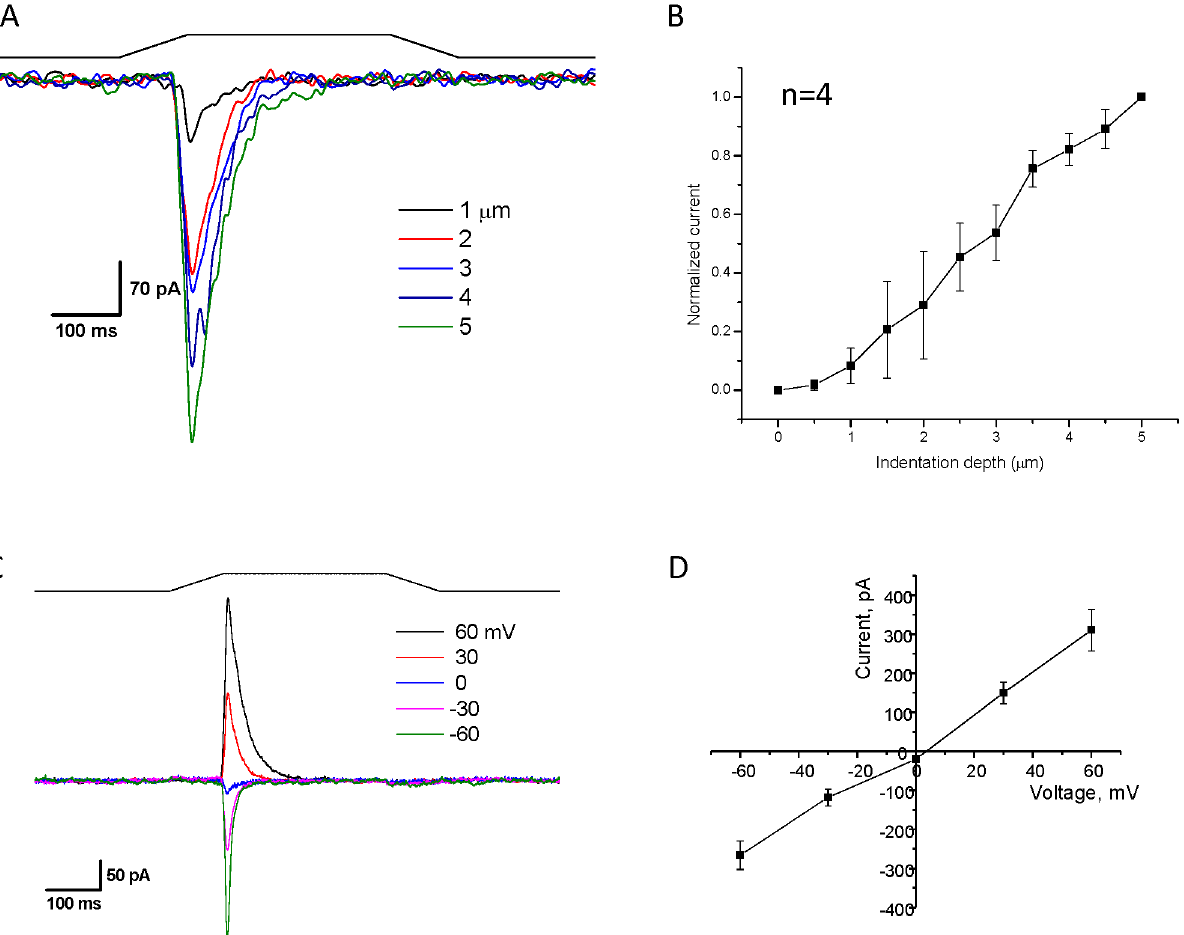
Fig 2. Two hPIEZO1 segments reassemble into a functional channel. A plasmid allowing for the expression of two protein segments (1 – 1591 with a mCherry protein attached to its C-terminal and 1592 – 2521 with an N-terminal GFP) was transfected into HEK293T cells. Cells were identified by both green and red fluorescent indicating that both parts of the protein were expressed. Panel A shows whole cell currents elicited with a fire-polished probe that mechanically stimulates the cell by pressing on the membrane (holding potential = -60 mV). The black line indicates the stimulus pulse. Panel B demonstrates that increasing depth of penetration produces more current (n = 6, error bars are S.D.) Panel C is a cell-attached current trace at the indicated voltages, and Panel D is a plot of the current versus voltage showing that the channel reverses around 0mV and is similar to the wild type channel (n = 4. error bars are